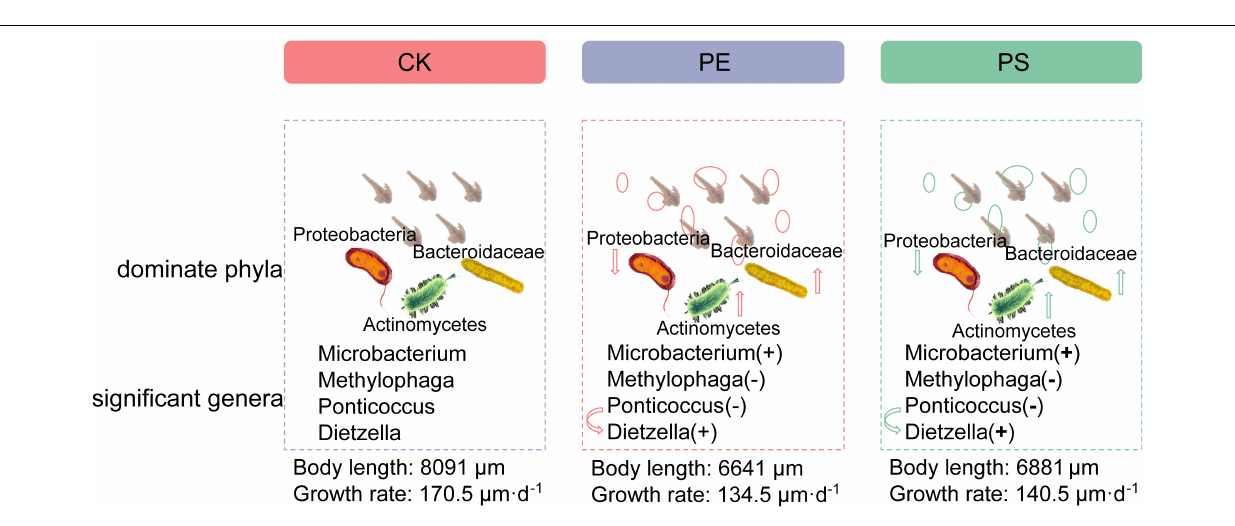
FIGURE 11 | Schematic of the effect of MP exposure on composition of intestinal microbiota (dominant phyla, significant genera) and growth of brine shrimp. “+” means high, and “ − ” means